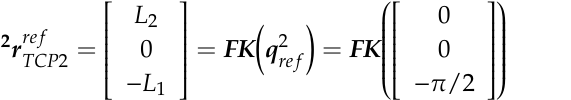
DUAL ARM SYSTEM